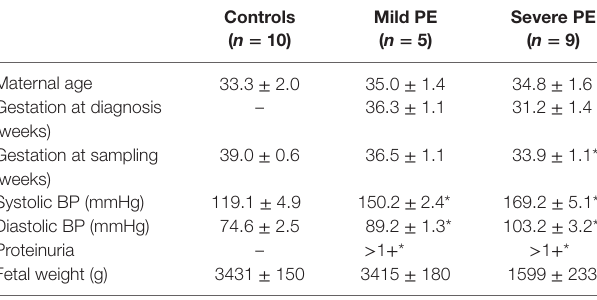
TaBle 1 | Clinical characteristics of recruited